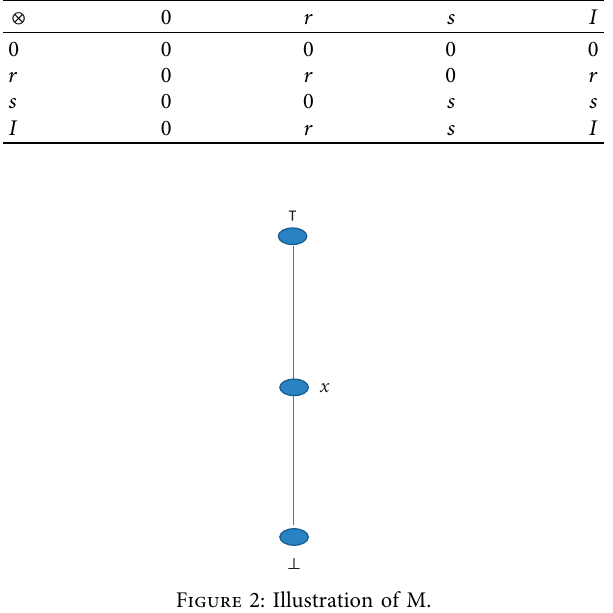
Table 1: Binary operation subject to ⊗ .